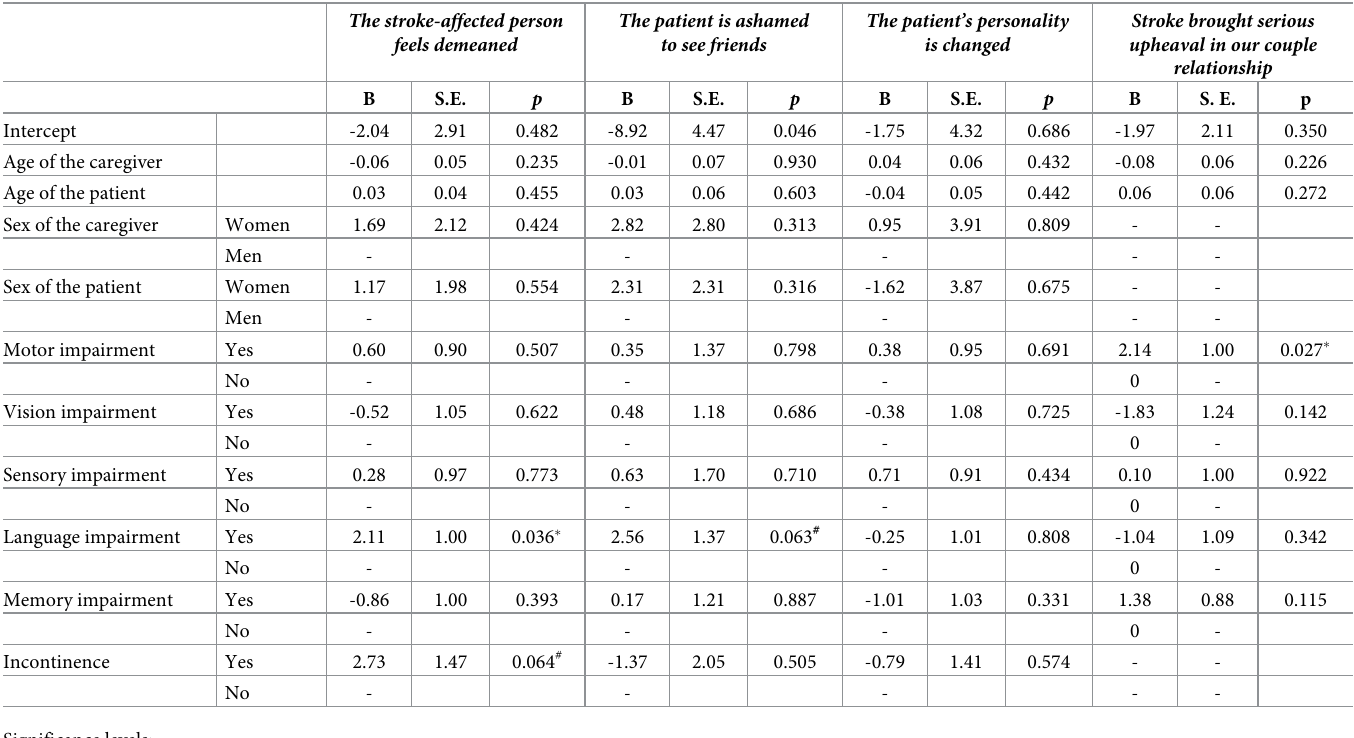
Table 4. Logistic regressions of the discordant groups for the four items.